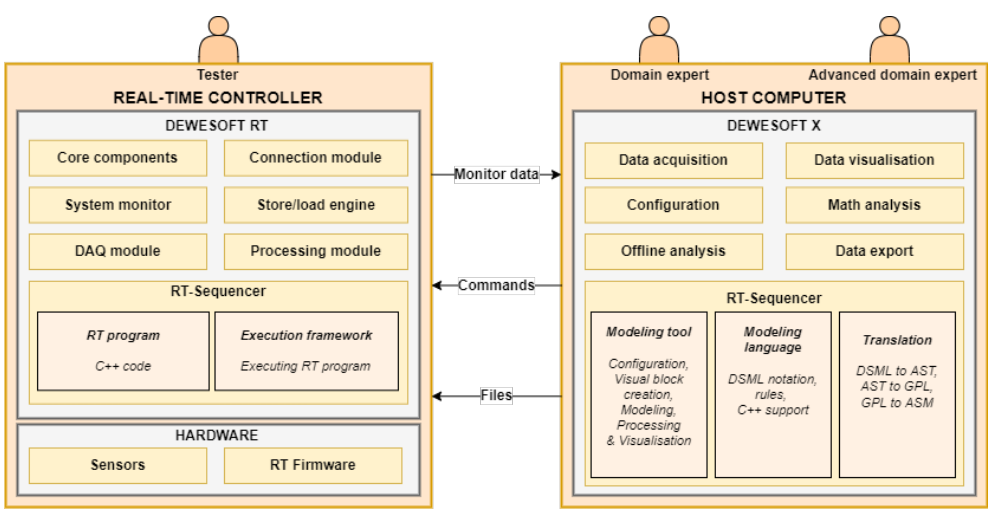
Figure 3. Domain architecture of the